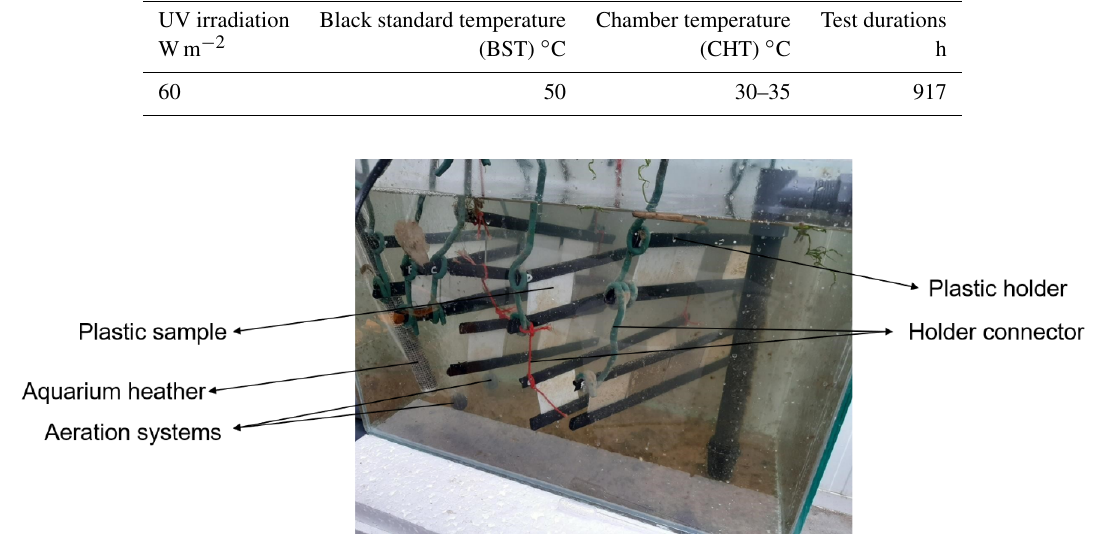
Table 2. Parameters of the UV chamber used in artificial weathering experiments.